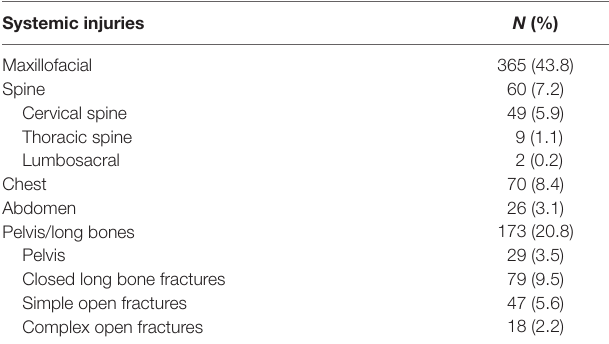
Table 3 | Road-traffic injury-related head injury from Nigeria: distribution of associated extracranial injuries.